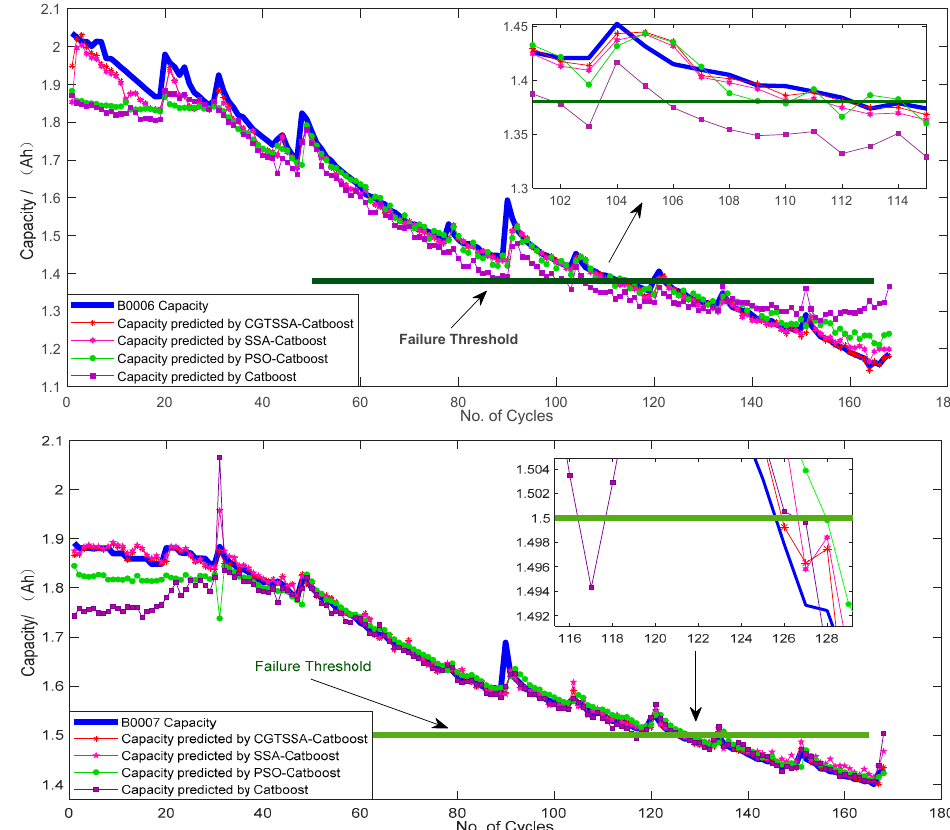
Figure 7. Prediction results of CatBoost model and its optimization model.